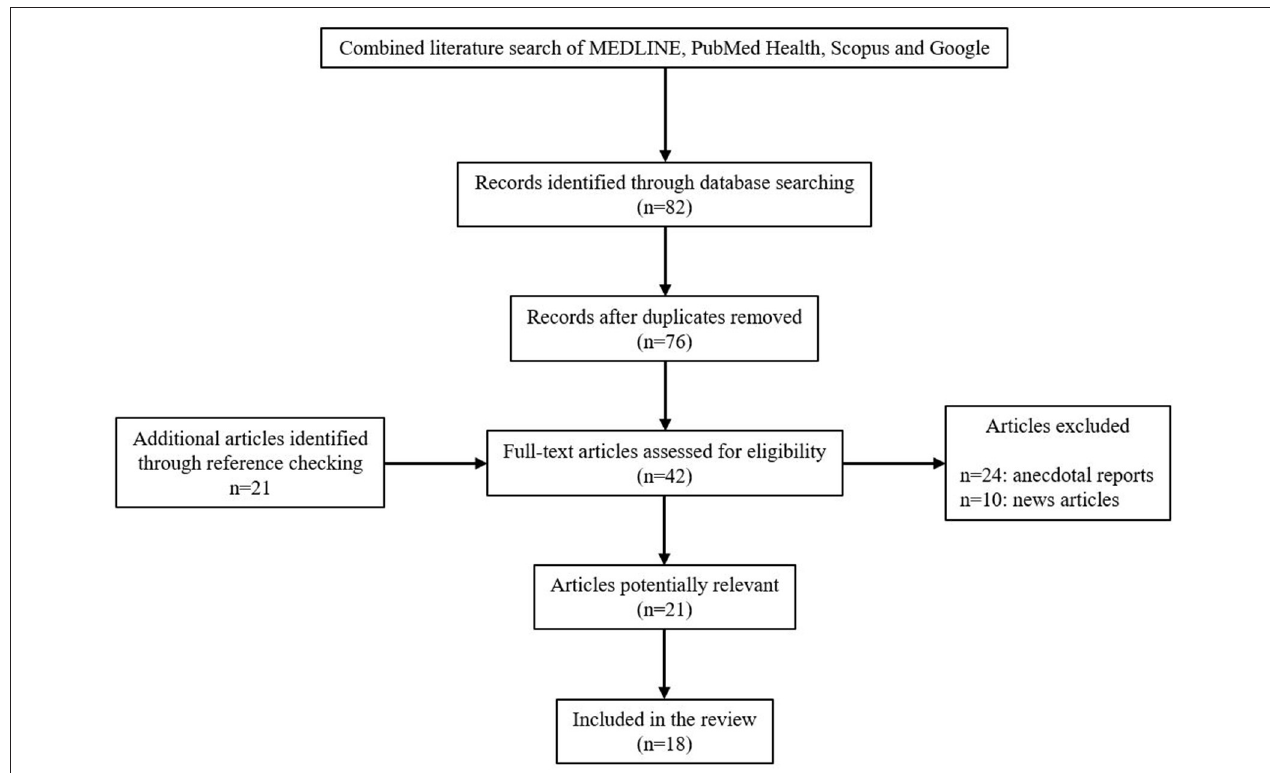
FIGURE 1 | Flowchart of the review